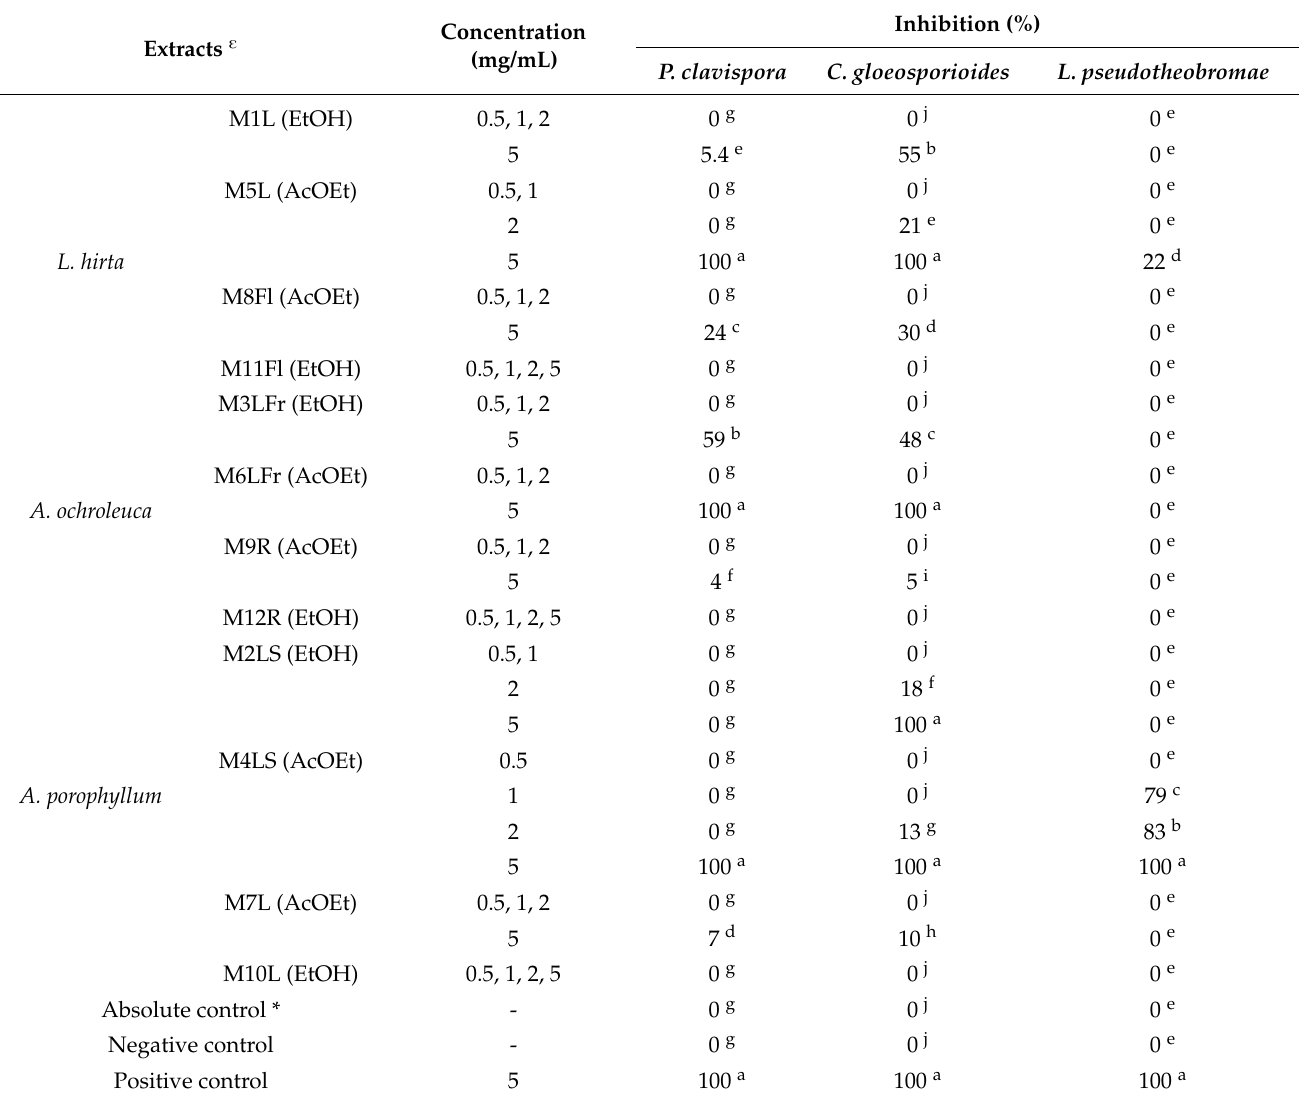
Table 1. Percentage of mycelial growth inhibition of phytopathogenic fungi of blueberry by crude extracts of L. hirta , A. ochroleuca and A. porophyllum